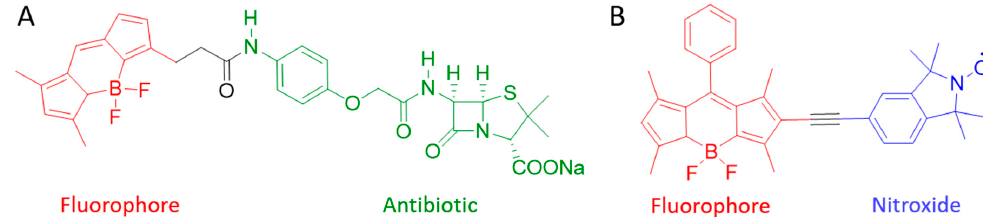
Figure 1. ( A ) The fluorescent antibiotic BOCILLIN TM FL penicillin (BOCILLIN-FL), an example of a fluorophore covalently linked to an antibiotic; ( B ) an example of a profluorescent nitroxide, based on the boron-dipyrromethene (BODIPY) fluorophore [17].